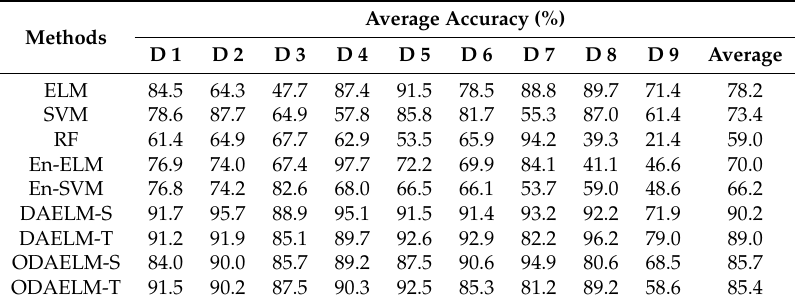
Table 4. Comparisons of final classification accuracies using setting 2.